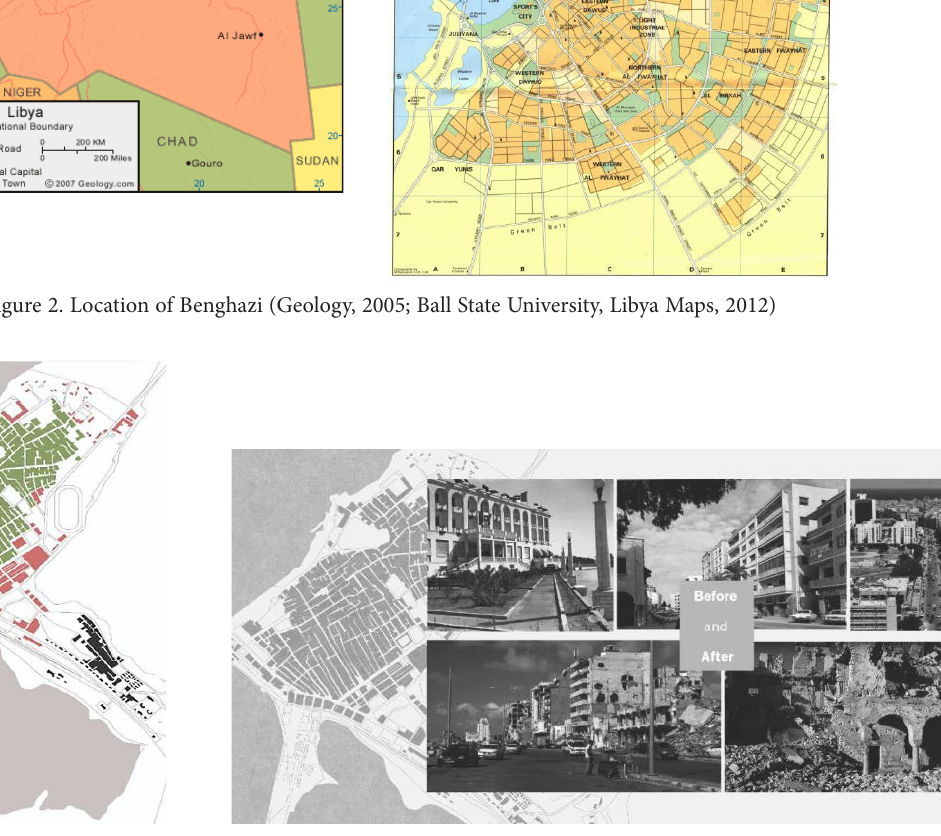
Figure 3. Show the Italian quarter around Figure 4. Images shows the War Destruction in Benghazi Recently the old city hazi downtown lacks gradation because the urban block formation methodology has stereotypical visual features and spatial patterns, in opposition to the urban fabric lev- els in heritage